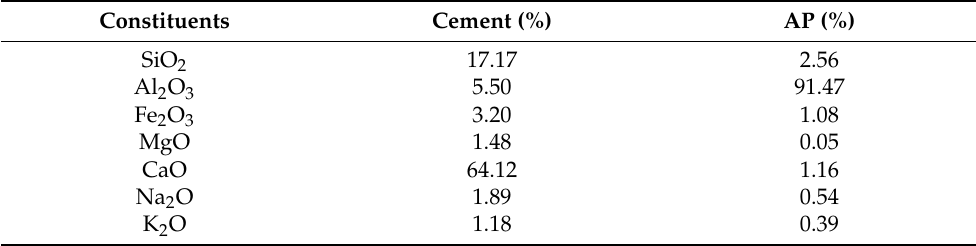
Table 1. Properties of used cement and AP.